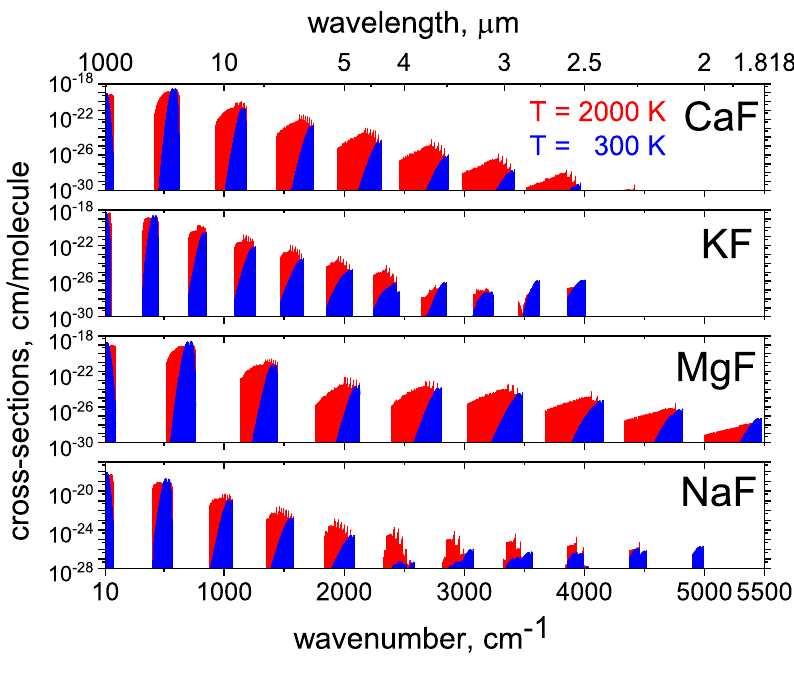
Figure 5. Absorption cross sections of CaF [37], KF and NaF [38], MgF